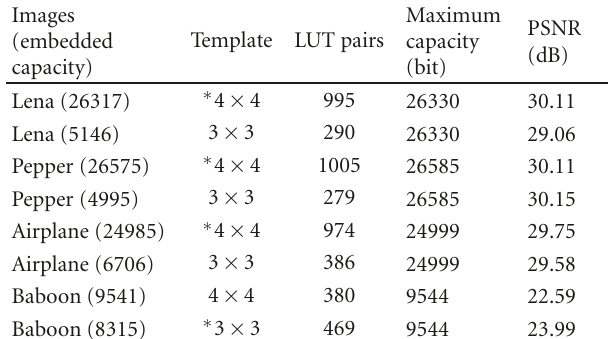
Table 1: The embedded capacity of LUT and maximumembedding